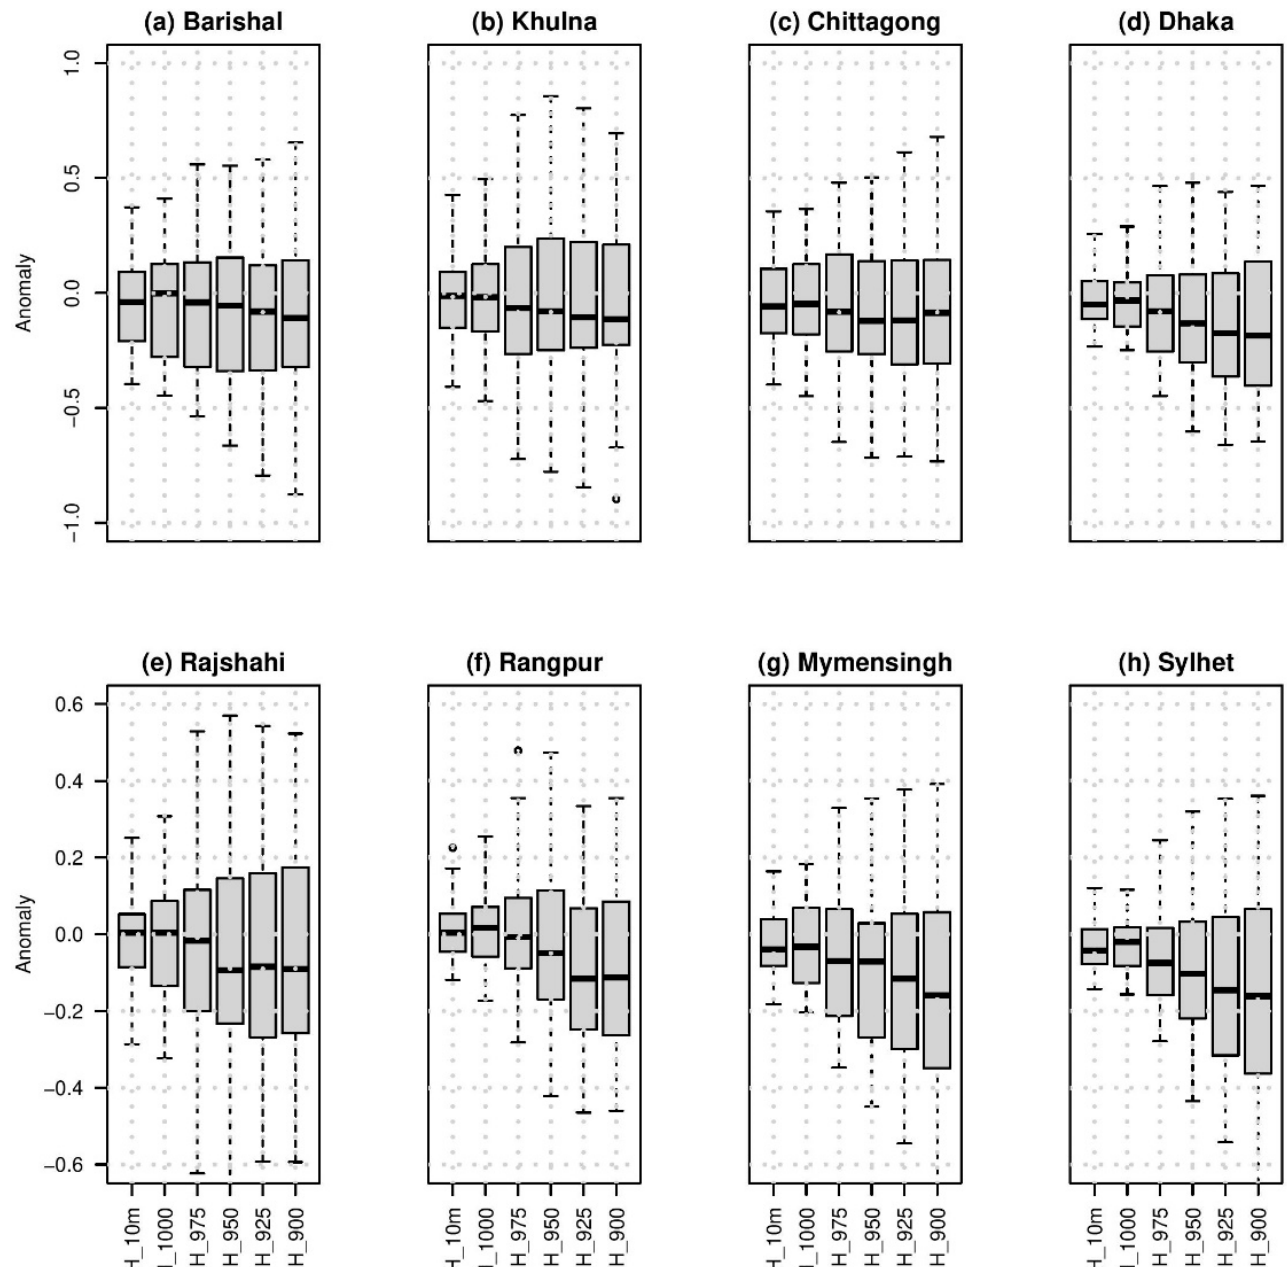
Figure 3. Same as in Figure 2, but valid for anomalies of wind speed.